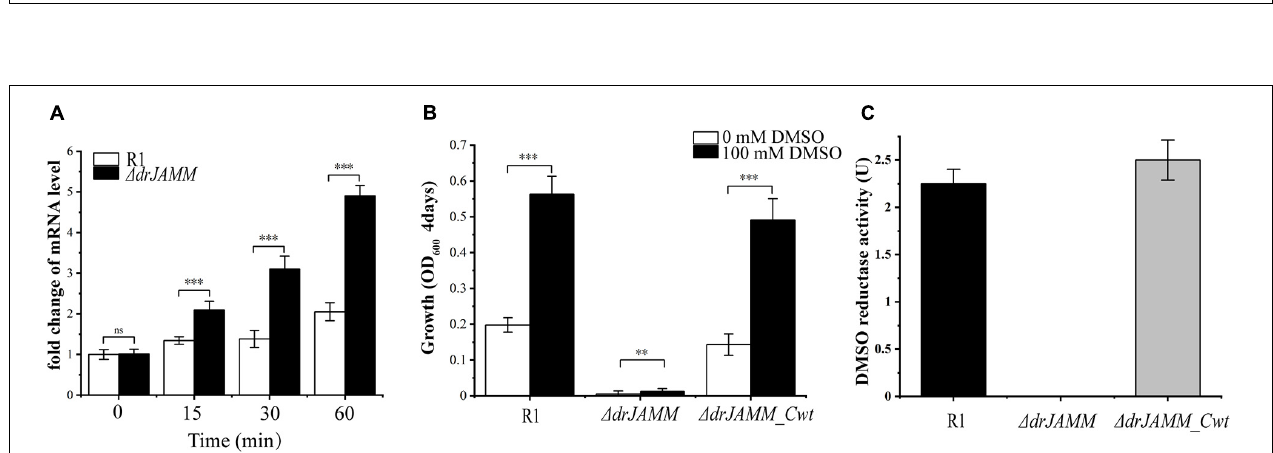
FIGURE 4 | Determination of levels of DMSO reductase under oxidative stress, growth of strains under anaerobic conditions, and the activity of DMSO reductase. (A) The mRNA levels of the DMSO reductase at different times following exposure to 40 mM H 2 O 2 in R1 and (cid:49) drJAMM. Values were means of three independent assays (mean ± SD), ns , not significant, ∗∗∗ p < 0.001. (B) Anaerobic growth of R1, (cid:49) drJAMM and (cid:49) drJAMM_Cwt in medium containing 0 or 100 mM DMSO for 4 days. Values were means of three independent assays (mean ± SD), ∗∗ p < 0.01, ∗∗∗ p < 0.001. (C) The DMSO reductase activity was monitored with nitrogen at A600 nm. The U was defined as 1 µ mol substrate consumed per minute at room temperature. Values were means of three independent assays (mean ± SD).